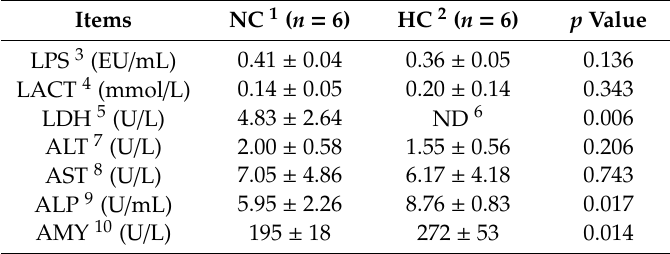
Table 6. E ff ects of high-concentrate diet on ileal parameters in twelve goats. Items